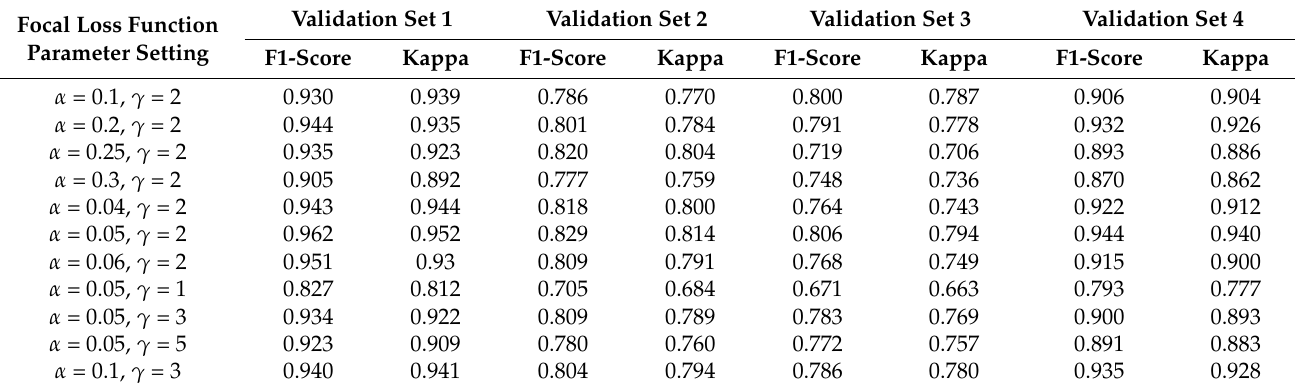
Table 4. Parameter setting and accuracy